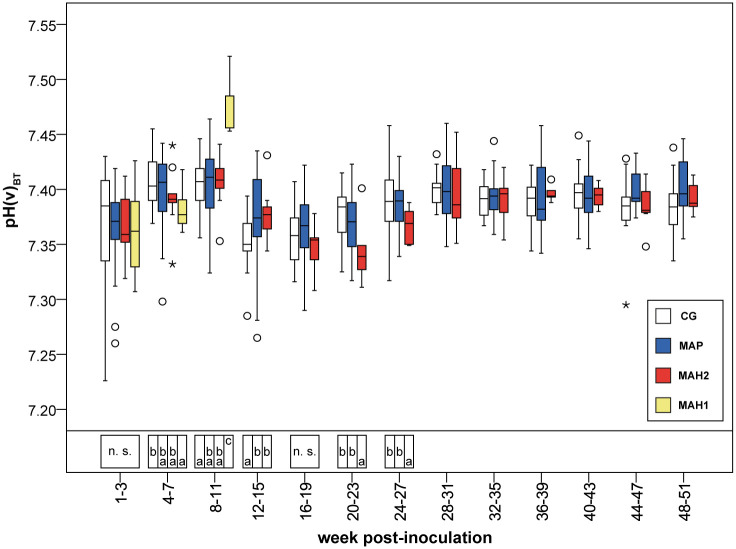
Measured pH values assessed in venous blood, corrected for actual body temperature.CG, control group. MAP, group infected with Mycobacterium avium subsp. paratuberculosis. MAH 1, sub-group infected with Mycobacterium avium subsp. hominissuis with acute, severe form of infection. MAH 2, sub-group with chronic form of infection. BT, body temperature (rectally measured before each blood collection). Different letters indicate significant differences between groups within one period (Mann-Whitney U-test, P < 0.05). n.s., no significant differences between groups in the given period. From 28th week onwards Mann-Whitney U-test was not performed due to reduced numbers of observations. Significant differences within groups (Friedman test, P < 0.05) from 1st-3rd to 24th-27th wpi are given in S3–S5, and S10 Tables.